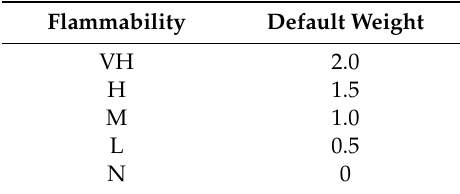
Table 4. Default flammability